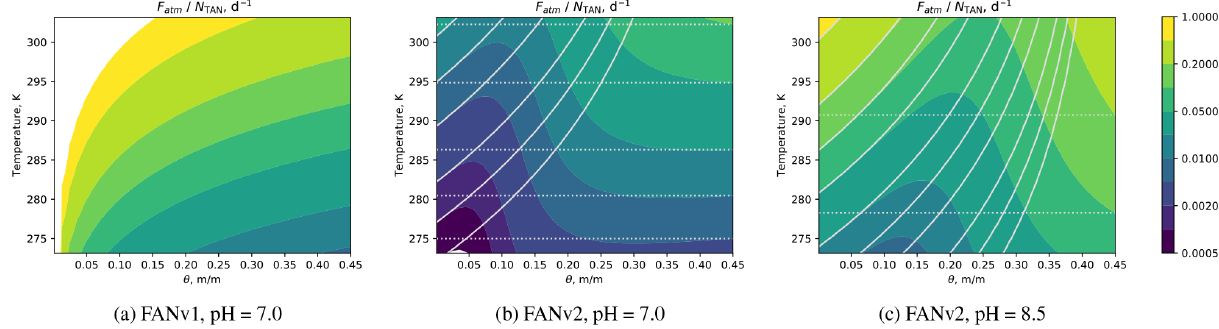
Figure 2. The instantaneous volatilization flux normalized with the TAN pool, F atm /N TAN (d − 1 ), as a function of temperature and volumetric soil moisture θ in FANv1 (a) in and FANv2 at pH = 7.0 (b) and pH = 8.5 (c) . In all figures, θ s = 0 . 45, R a + R b = 200 . 0sm − 1 , and Q r = 0. The contour lines correspond to the approximations at low (solid) and high (dotted lines) water content θ (Eqs. A21 and A22).